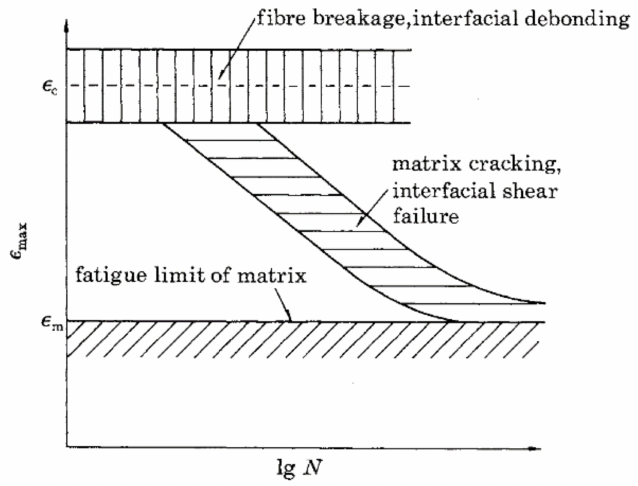
Figure 3. Maximum strain vs. logarithmic number of cycles to failure, reprinted with permission from ref. [20]. Copyright 1981 The Royal Society.